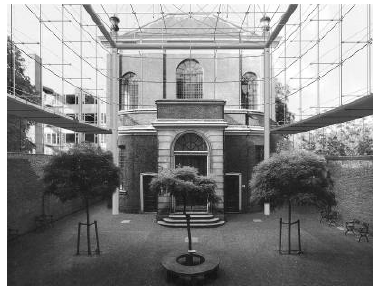
Figure 15: Interior of the Glass Cubical Hall for the synagogue in The